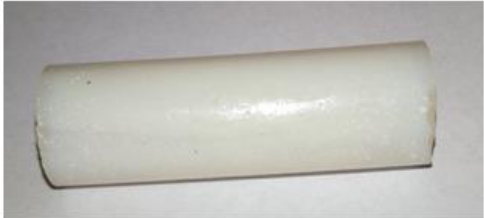
Figure 2. Specimens of E5 / Z-1 / 100:12 epoxy compound after milling